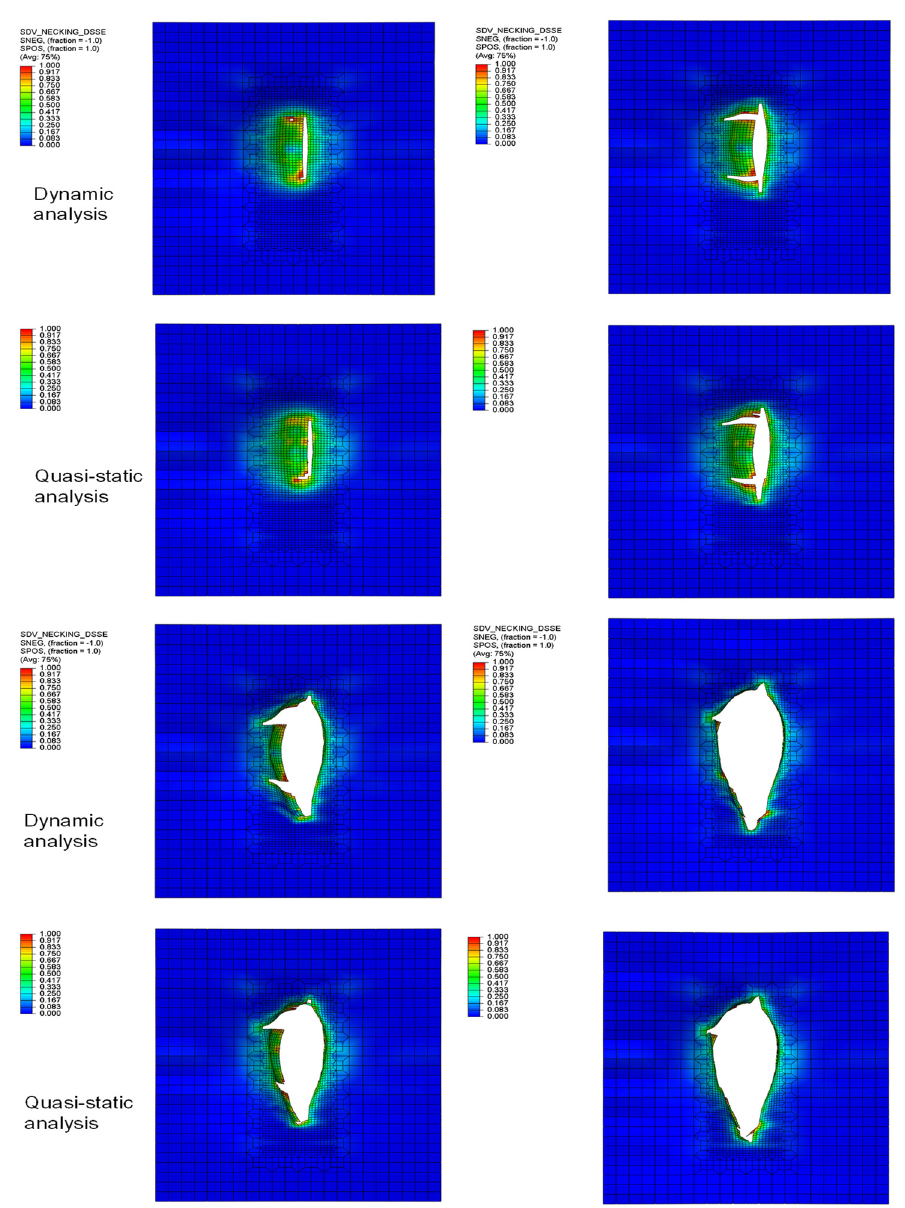
Figure 10. Different stages of rupturing of the outer shell predicted in dynamic and quasi-static analyses.